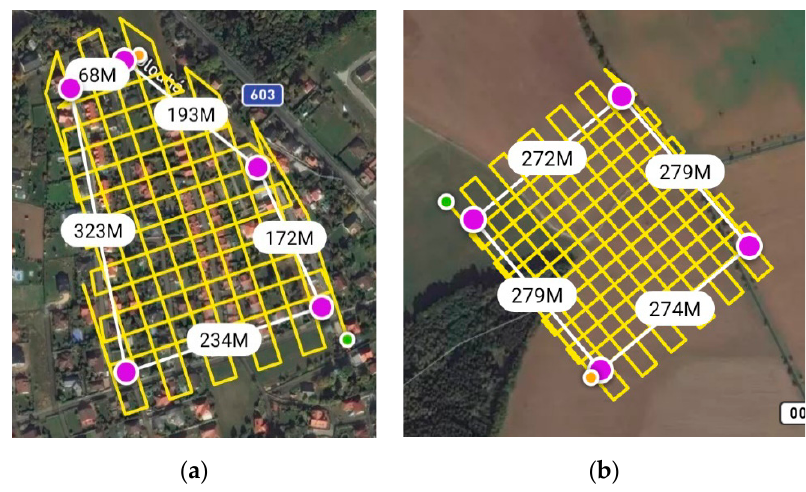
Figure 3. Flight trajectory for the Urban ( a ) and Rural ( b ) areas including distances.